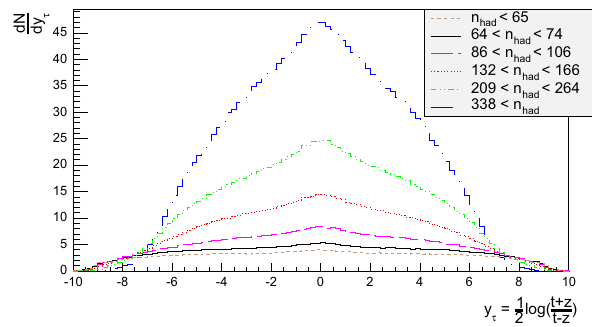
Fig. 23 Longitudinal spectra for 13 TeV pp collisions and different multiplicity